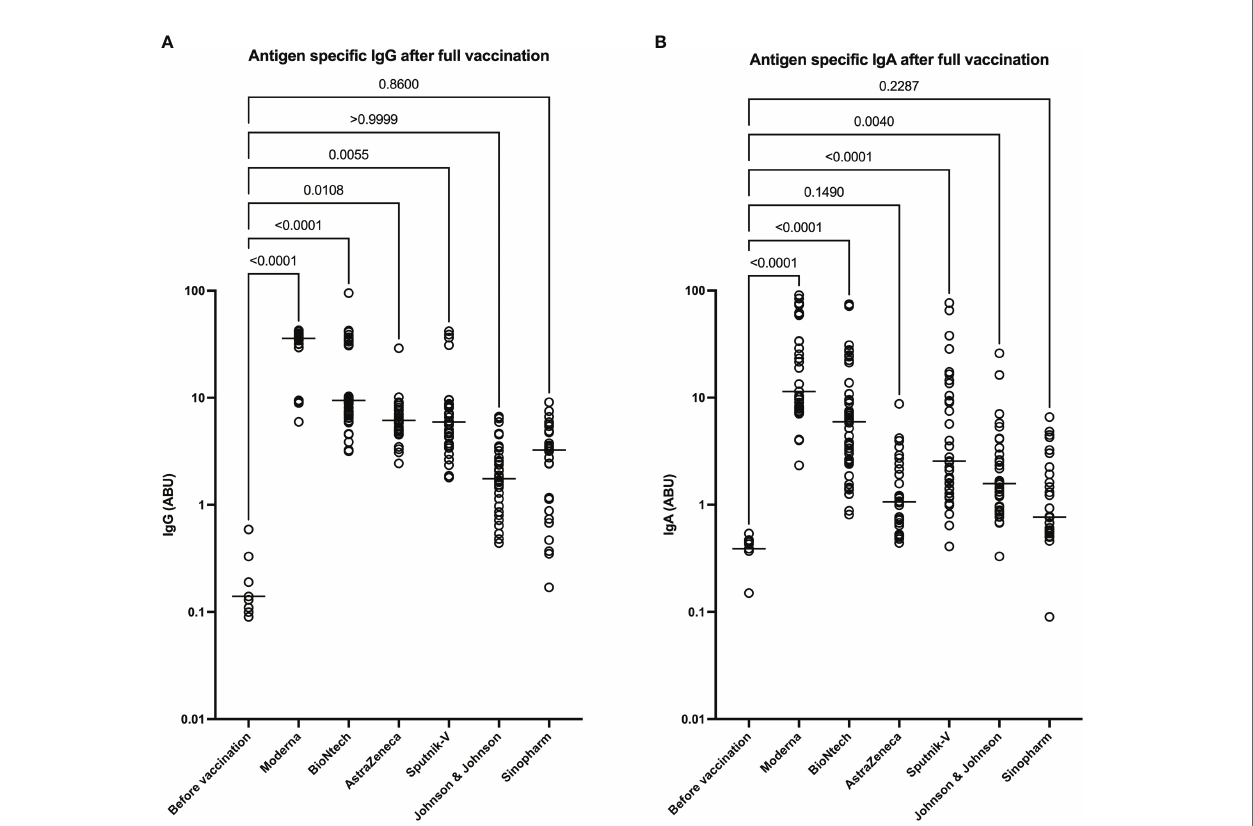
FIGURE 2 | Higher expression of SARS-CoV-2 reactive IgG and IgA after immunization mRNA vaccines. Graphs represent the expression SARS-CoV-2 spike- protein binding IgG (A) and IgA (B) in arbitrary binding units (ABU). Each symbol represents individual donors. Indicated p values were calculated using the Kruskal- Wallis test followed by Dunnett ’ s post hoc to compare each group to the controls before vaccination. Bars represent the median antibody expression in each group. Signi fi cance is accepted if p